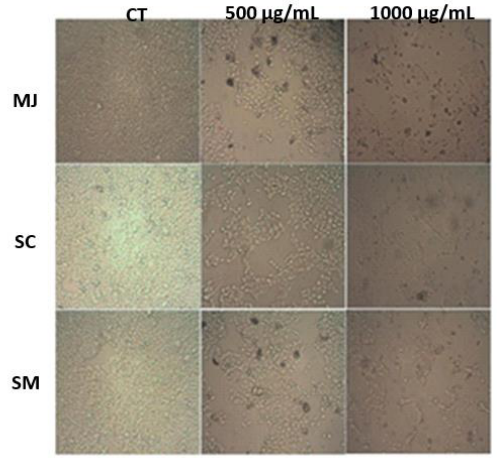
Figure 3. Photomicrographs from phase-contrast microscopy of HT-29 cells treated with dried peel powders (500 and 100 µg/mL) extracts of M. jaboticaba (MJ), S. cumini (SC), and S. malaccense (SM). Phase-contrast images were taken from random fields (80 µm).